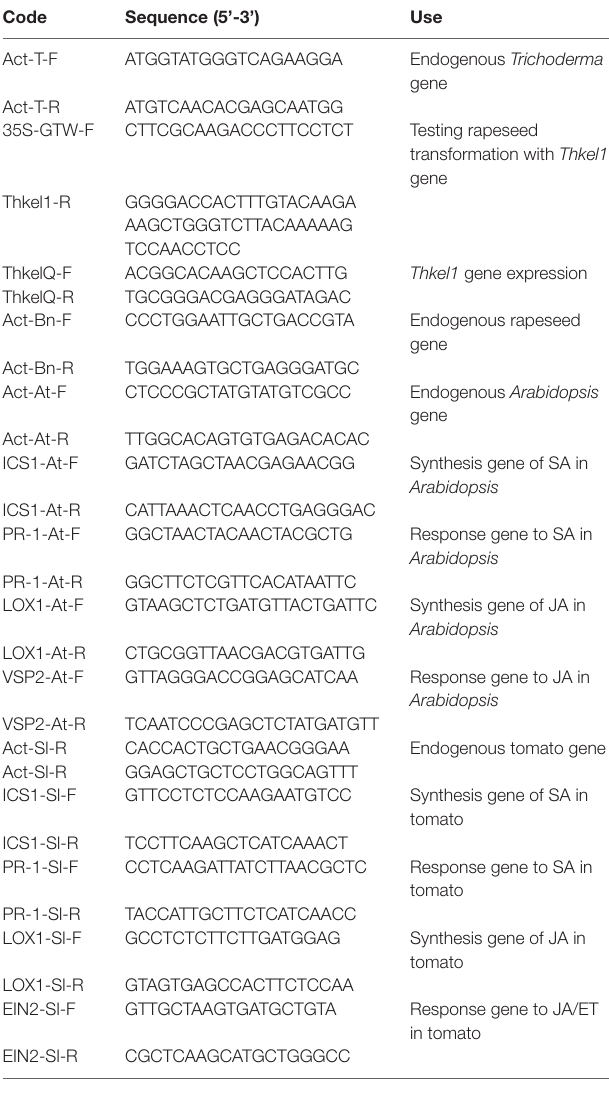
TaBLE 1 | Oligonucleotides used in this